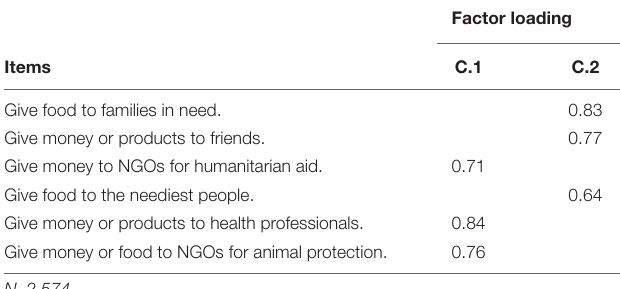
TABLE 2 | Prosocial behavior items and factor loading.